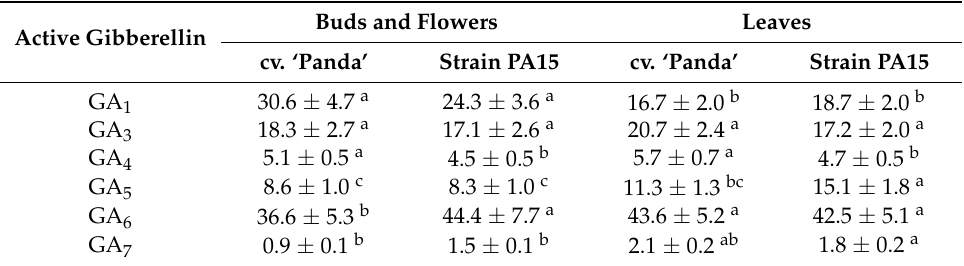
Table 3. Content of individual active gibberellins in relation to the total pool of active gibberellin forms in the buds, open flowers, wilted flowers, and leaves of the cv. ‘Panda’ and PA15 strain plants grown at 20 ◦ C and 30 ◦ C. Means for the buds and flowers ( n = 9) and means for the leaves ( n = 3) ± SE. Buds and Active Gibberellin